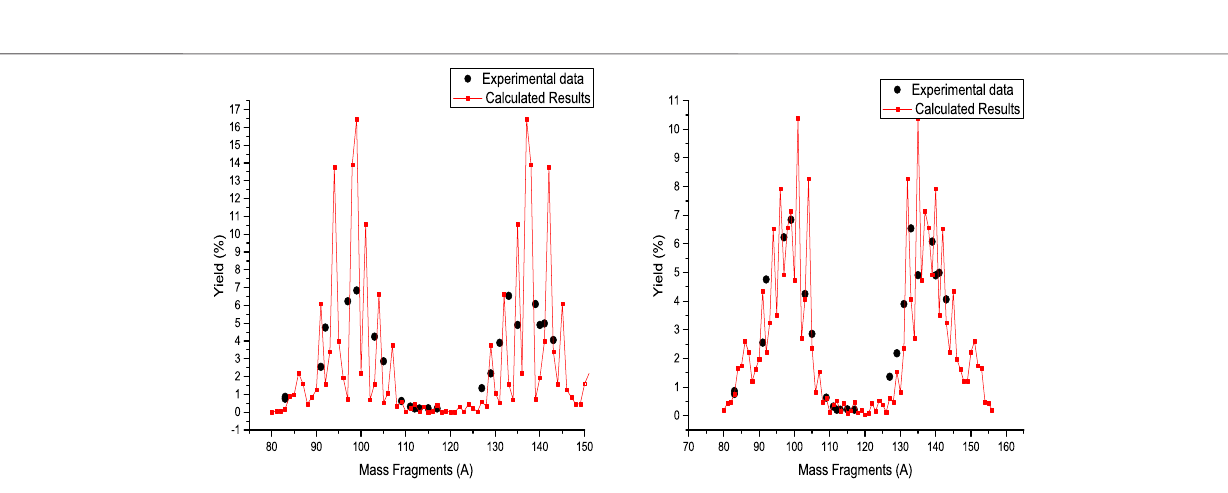
FIGURE 6 | Calculated mass yield for photo fi ssion of 237 Np at 25 MeV bremsstrahlung endpoint energy, accompanied by experimental data [41]. In the left and right sides are presented the calculated results obtained for T coll (cid:1) 1 MeV and T coll (cid:1) 2 MeV, respectively.